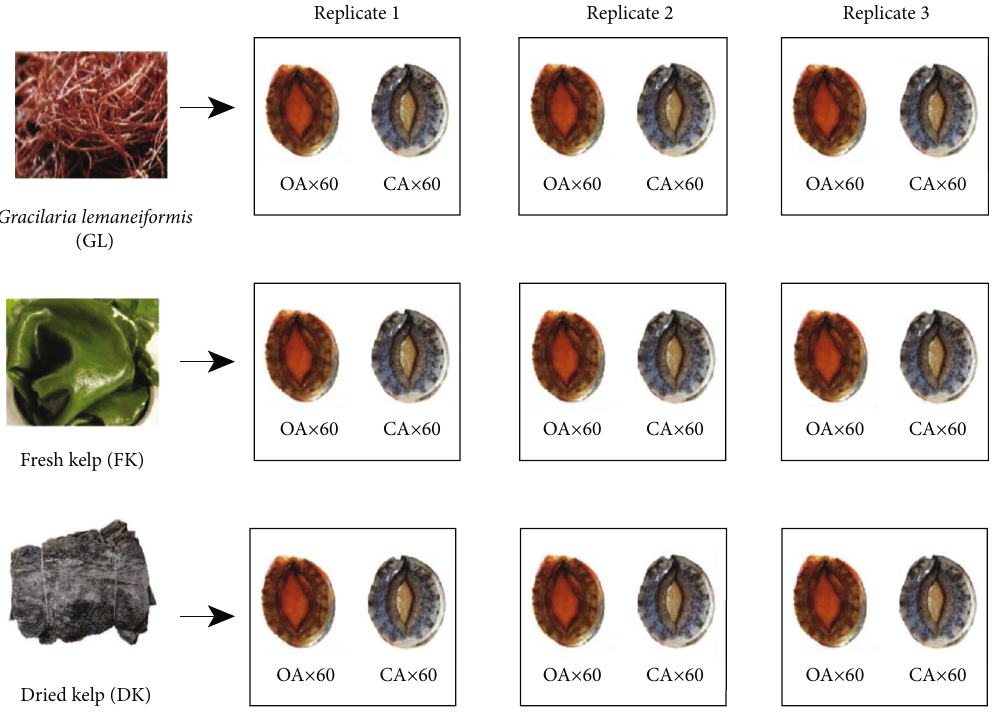
Figure 1: Experimental